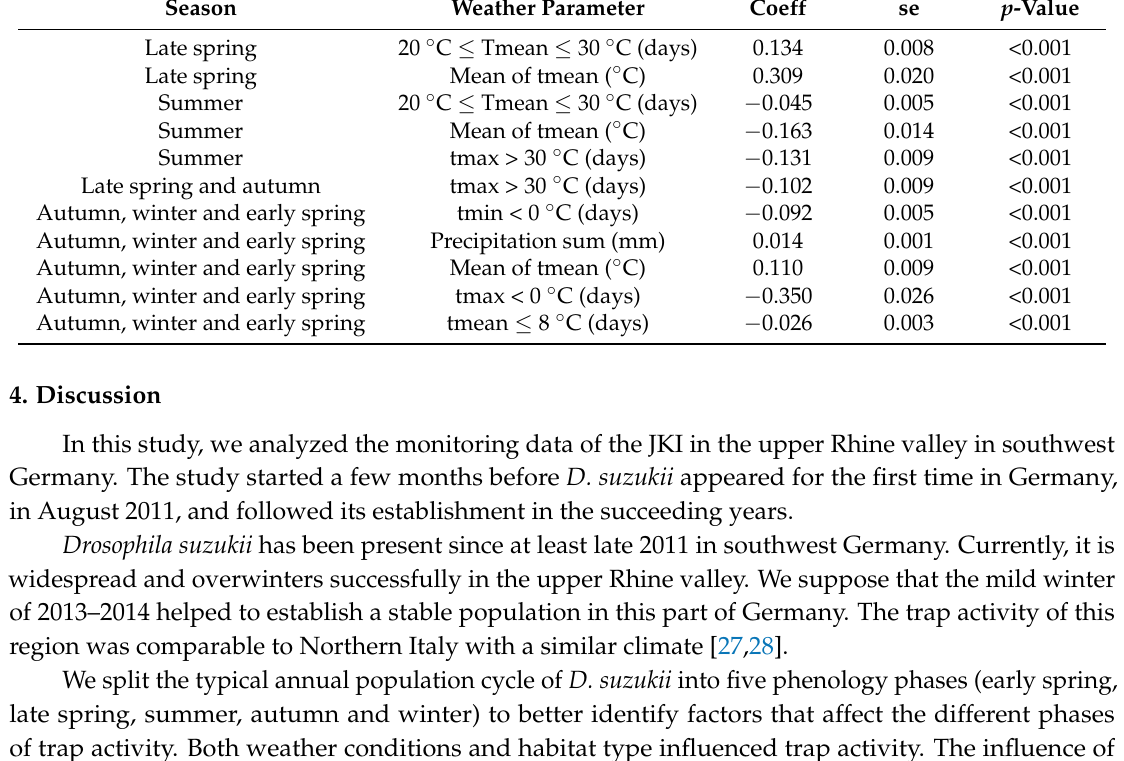
Table 6. Results from regression tests of seasonal captures against weather parameters. Shown are only parameters with significant p -values. ‘coeff’ is the regression coefficient, ‘se’ the standard error. Coeff se p